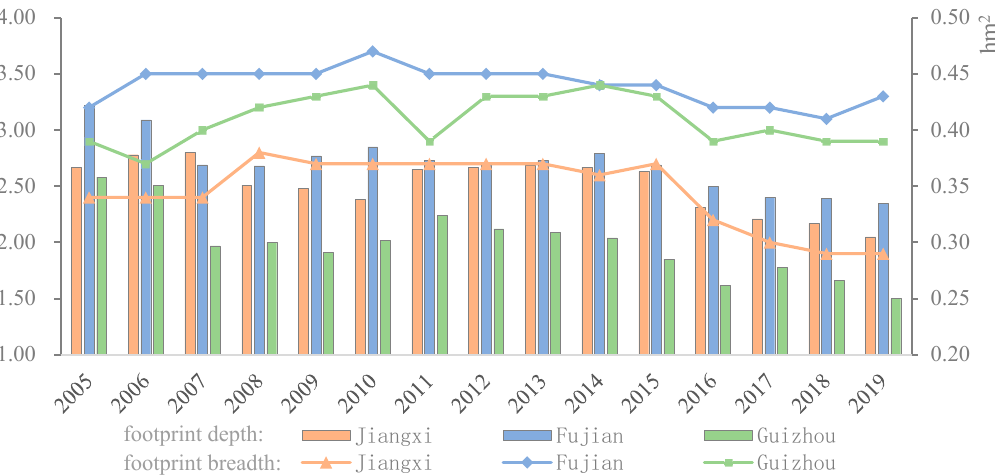
Figure 4. Per capita Footprint depth and footprint breadth in the National Pilot Zones for Ecological Conservation. Table 3. Ecological pressure index